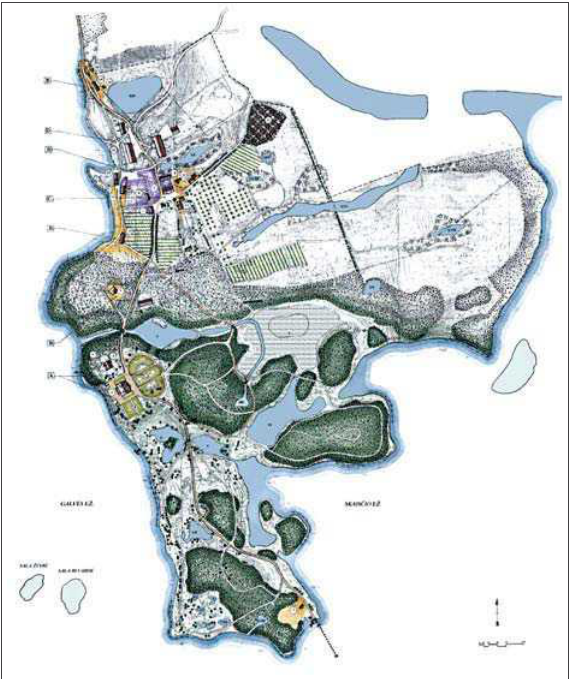
Fig 6. Originality of Užutrakis manor homestead must be preserved. Special territory planning by arch R. Stulpinas